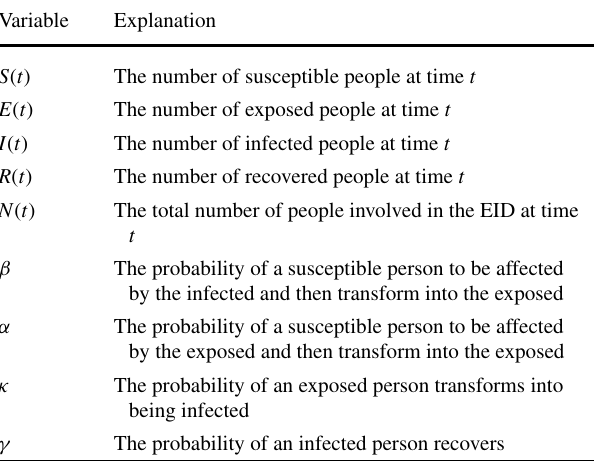
Table 1 Parameters of